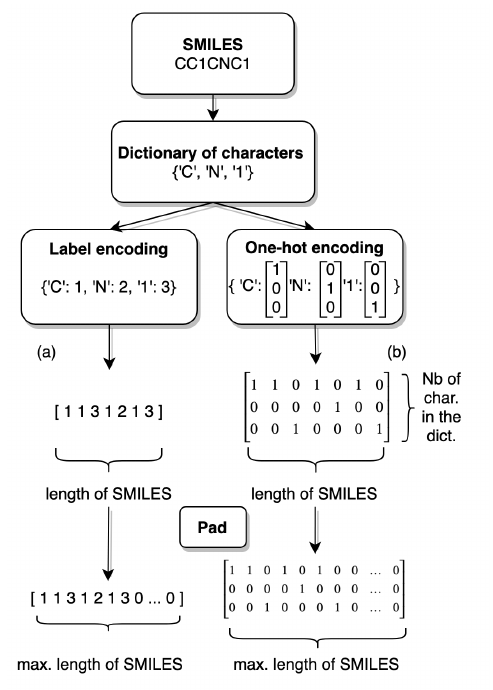
Figure A1. Encoding and padding. Starting from a SMILES string, the characters can be stored in a dictionary (or the dictionary can be constructed prior using a set of known characters). Label encoding consists of enumerating the characters in the dictionary. One-hot encoding consists of assigning a binary vector to each character. ( a ) Constructing the label encoding for a given SMILES by assigning the integer associated to the character as they appear in the SMILES. ( b ) Constructing the one-hot encoding by concatenating the binary vectors of the characters as they appear in the SMILES. (Pad) Inputs of same dimension are often required when using machine learning. A common solution is to use padding, which consists of adding zeros to either the label vector or to the one-hot matrix up to the maximum length of the SMILES in the data